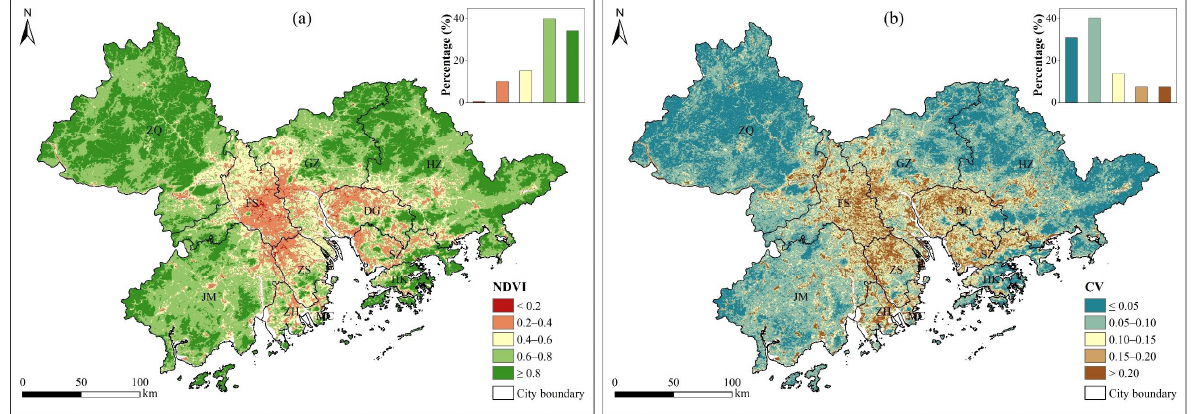
Figure 2. Spatial distribution of NDVI ( a ) and CV ( b ) in the GBA during 2001–2020. NDVI—normalized difference vegetation index; CV—coefficient of variation. Table 2. Area statistics of NDVI and CV for main LUCC types.